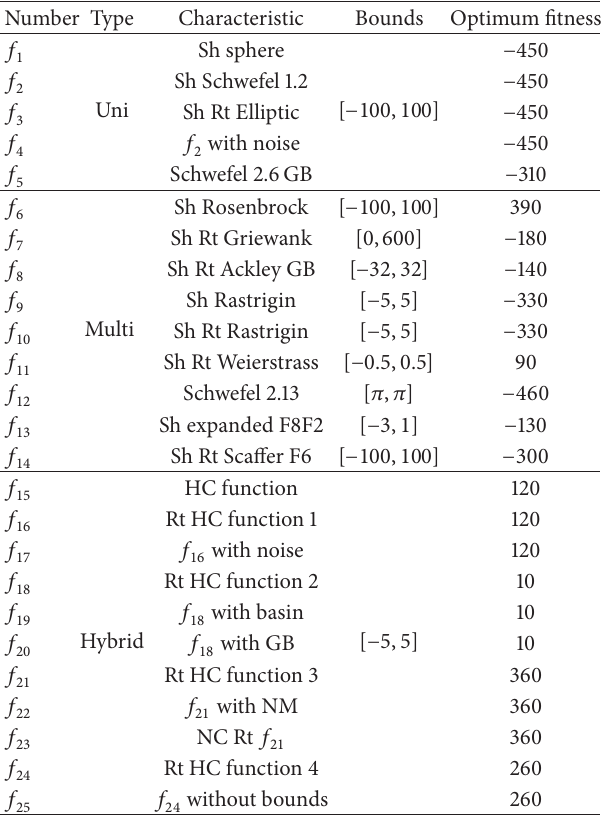
Table 1: Test functions (Uni = unimodal, Multi = multimodal, Sh = shifted, Rt = rotated, GB = global on Bounds, HC = hybrid composition, and NM = number